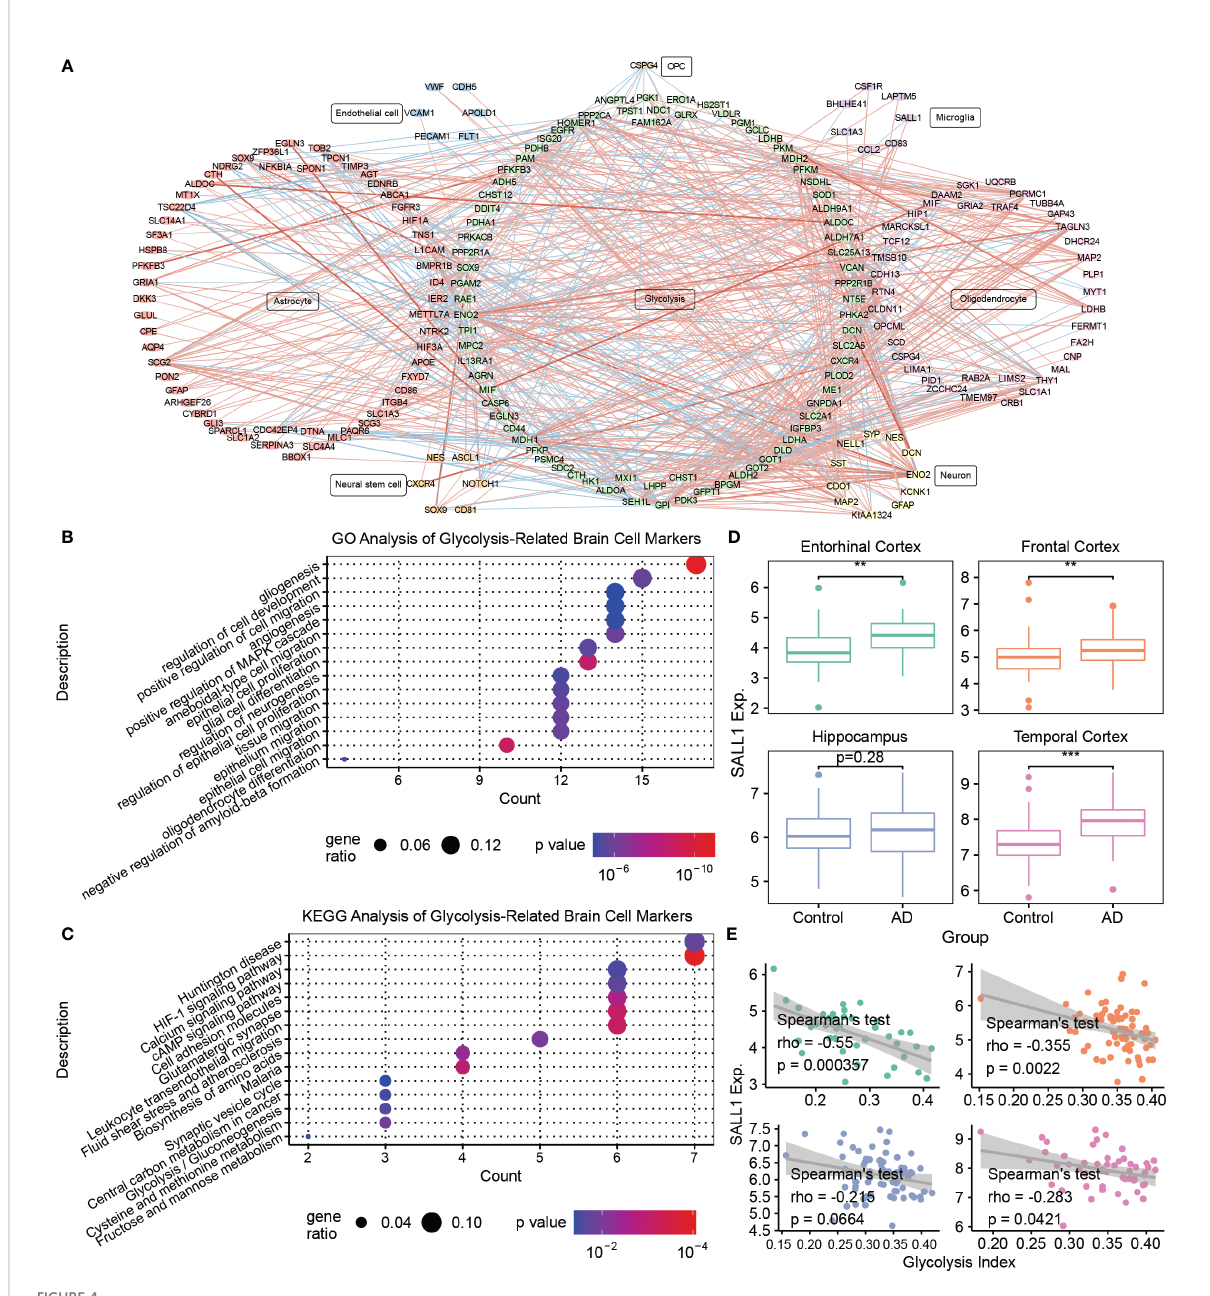
FIGURE 4 Mining of glycolysis-related brain cell markers (A) The correlations between glycolysis-related genes and various brain cell marker genes. The thickness of the line denotes the number of metrics supporting the correlation. The red line denotes a positive correlation, whereas the blue line denotes a negative correlation. (B) The GO enrichment analysis of glycolysis-related brain cell markers. (C) The KEGG enrichment analysis of glycolysis-related brain cell markers. (D) Boxplots of SALL1 expression in different brain regions between the control and AD samples. (E) Spearman ’ s correlation analysis between the glycolysis index and SALL1 expression. **p<0.01, ***p<0.001. AD, Alzheimer ’ s disease; GO, gene ontology; SALL1, Spalt Like Transcription Factor 1; and KEGG, Kyoto Encyclopedia of Genes and